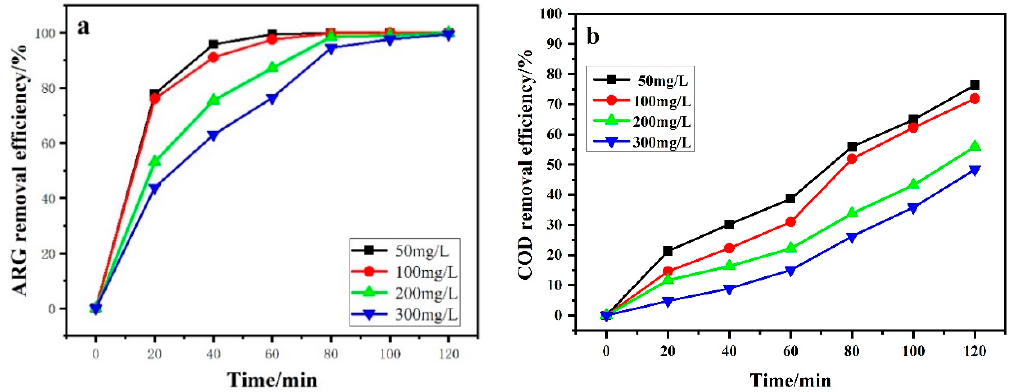
Figure 7. E ff ect of dye concentration on ARG removal e ffi ciency ( a ) and COD removal e ffi ciency ( b ). Other operating conditions: Current density of 50 mA / cm 2 and temperature of 25 ◦ Figure 7. Effect of dye concentration on ARG removal efficiency ( a ) and COD removal efficiency ( b ). Other operating conditions: Current density of 50 mA/cm 2 and temperature of 25 °C .